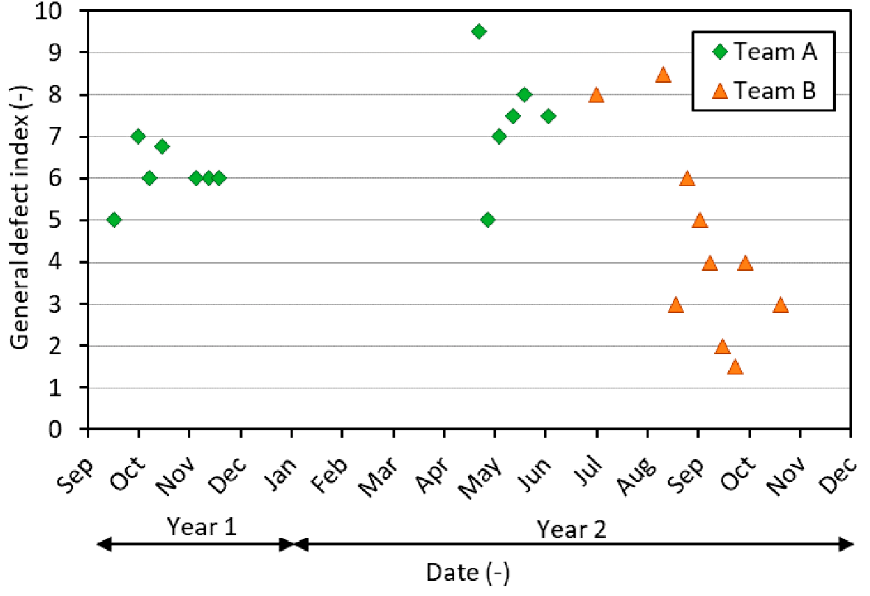
Figure 11. Relation between the defect index and the production date of the foundations.